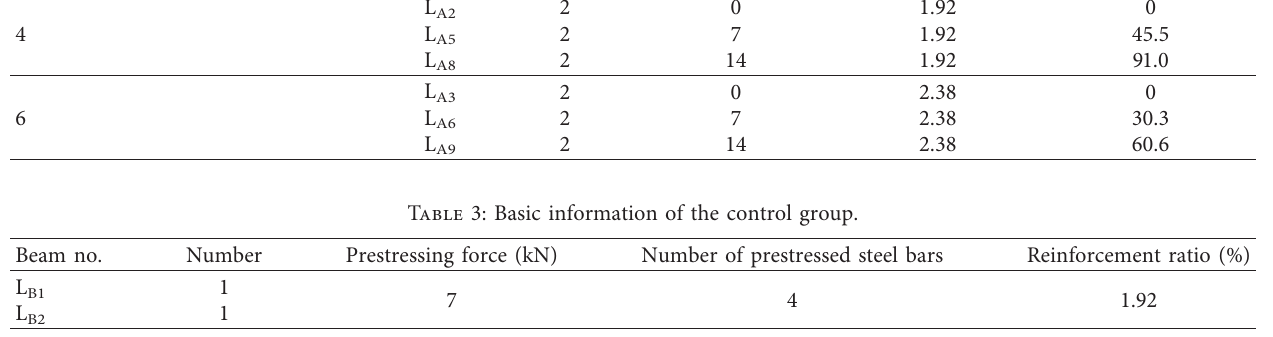
Figure 3. JM3813 static strain acquisition systems were applied to collect the strain and deflection measurements.